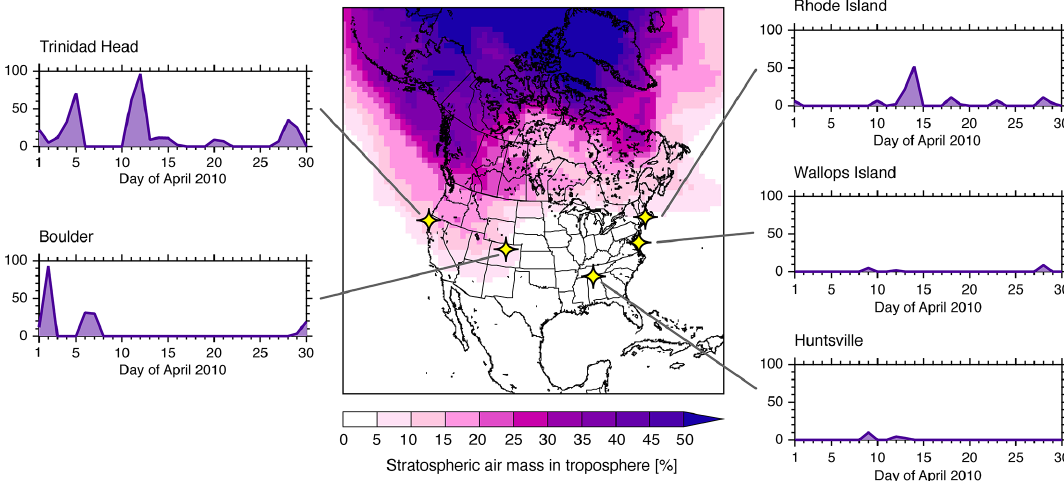
Figure 11. Spatial distributions of monthly averaged stratospheric air mass contributions to total tropospheric O 3 column over the US during April 2010. Yellow stars indicate the ozonesonde observational sites, and the daily variations are